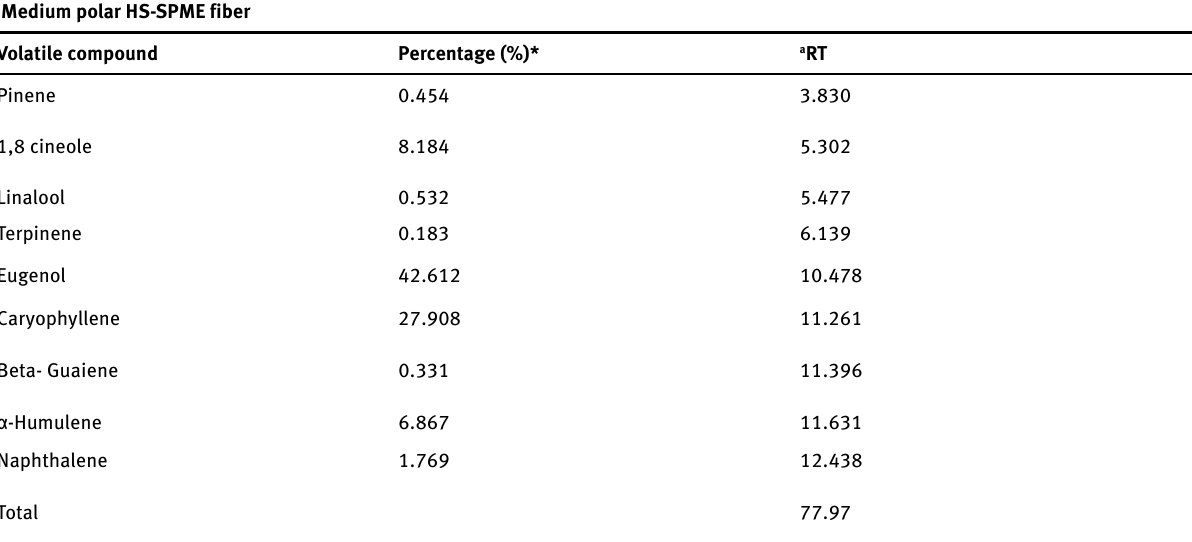
Table 3: Solid- Phase Microextraction of P. dioica leaf oil with Medium Polar SPME fiber